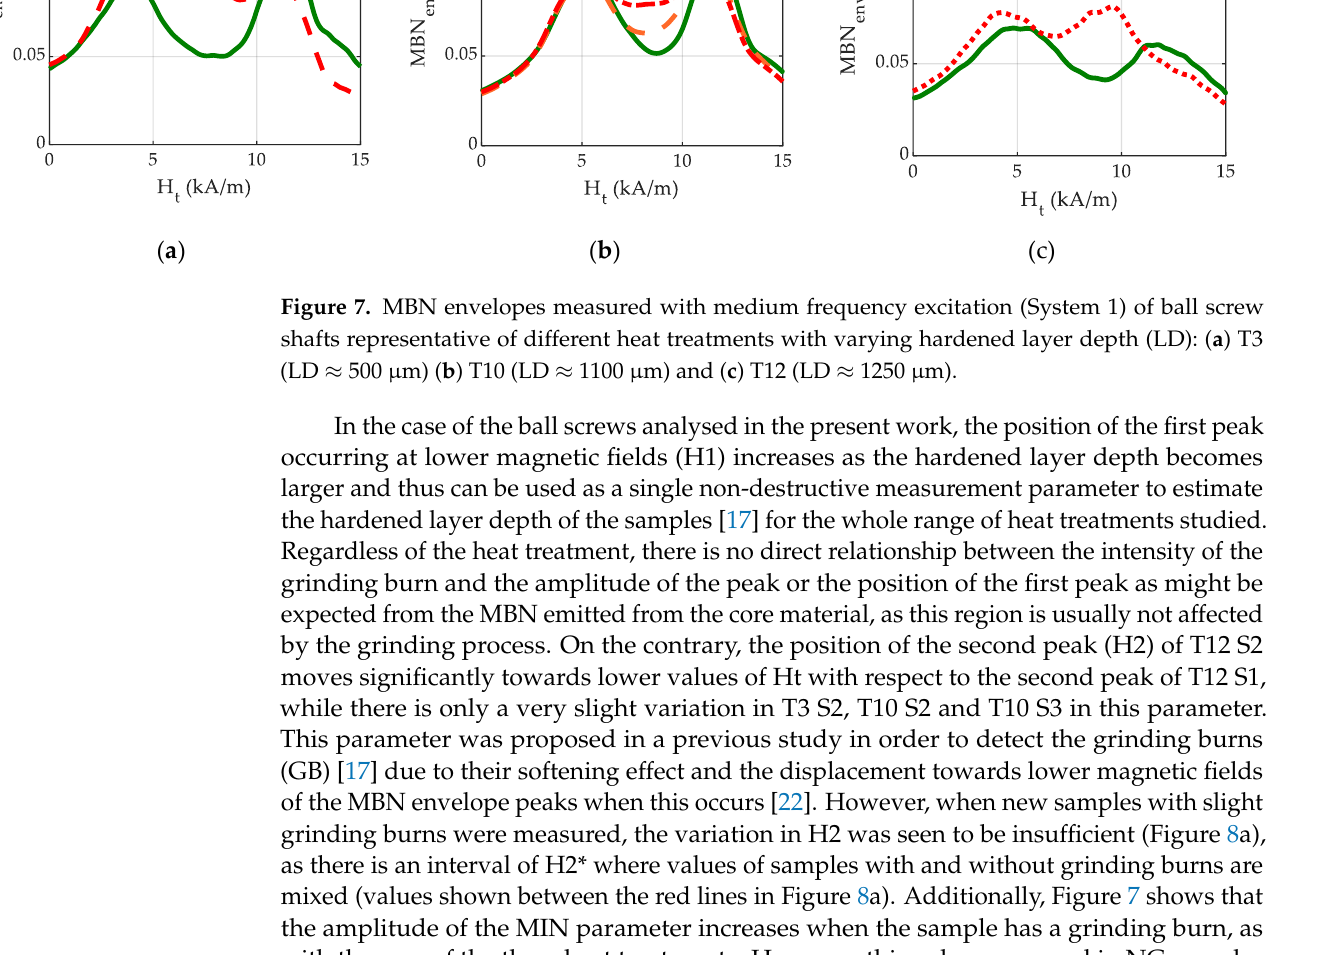
Figure 8. ( a ) The minimum value of the H2 parameter (H2*) and ( b ) the mean value of MIN param- eter (MIN*) measured along the ball screw helical path for the whole set of ball screws separated into groups: n ormally ground parts (“NG parts”), abnormally ground parts (“AG parts”), correct parts (without grinding burn (GB)) verified via destructive testing (DT) (“DT without GB”) and parts with grinding burn (GB) verified via destructive testing (DT) (“DT with GB”). Standard devi- ation value of H2* is 210 A/m and of MIN* is 0.6 mV.